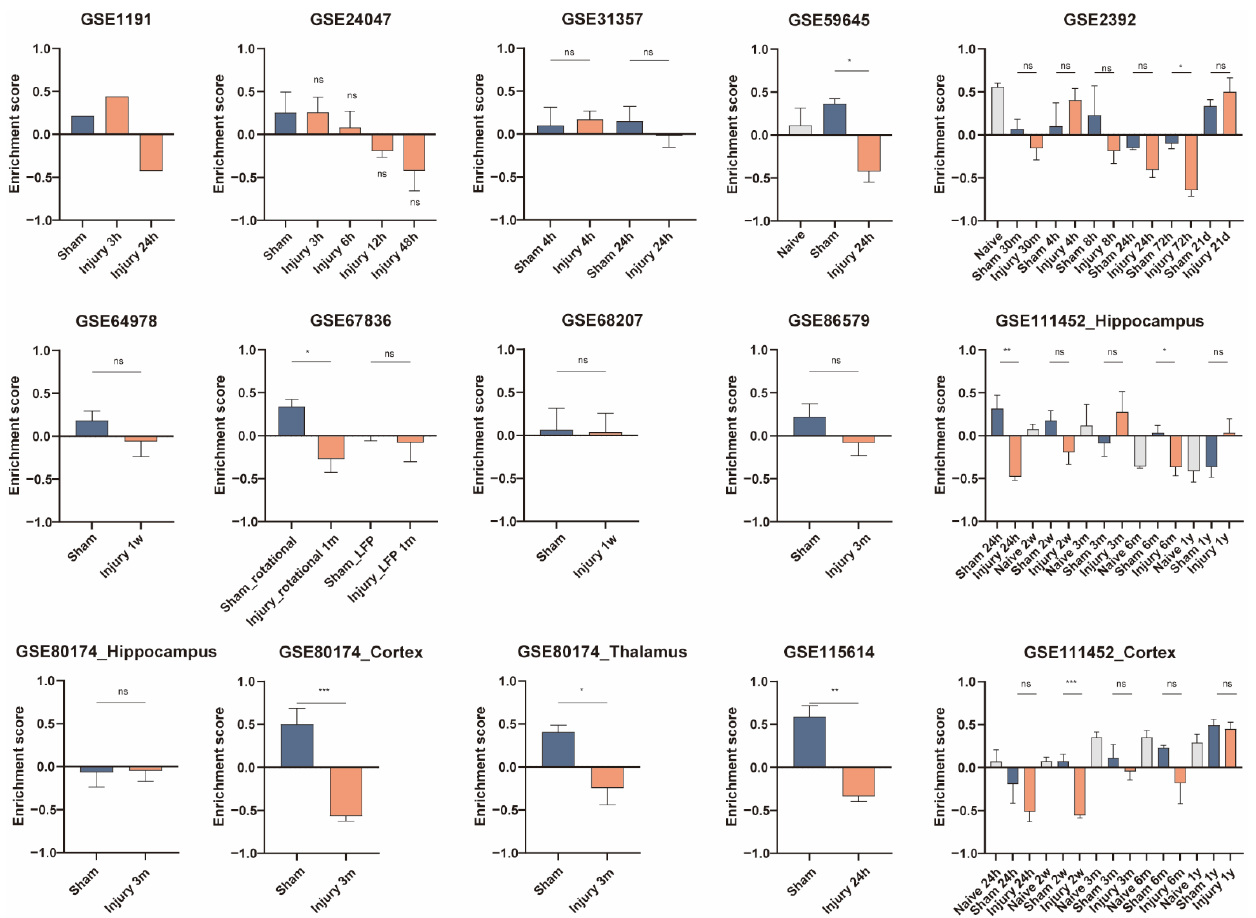
Figure 7. Gene set variation analysis (GSVA) for neuron in the validation datasets. GSVA enrichment scores from the validation data sets are plotted as bar graphs. The GEO accession number of the dataset is labeled in each panel. Samples from multiple regions in one dataset are compared separately. Information is labeled in the corresponding panels if the dataset contains samples with different treatments or harvested at various postinjury time points. For GSE1911, N = 1 for each group; for GSE24047, N = 4 for Sham group and N = 3 for the other groups; for GSE31357, N = 4 for each group; for GSE59645, N = 2 for Sham group and N = 3 for Naïve group and Injury 24-h group; for GSE2392, N = 3 for Naïve, Injury 4-h, Injury 8-h, Injury 24-h, Injury 72-h, and Injury 21-d groups, N = 4 for Sham 30-m and Sham 4-h groups, N = 5 for Injury 30-m group, N = 2 for Sham 8-h, Sham 24-h, Sham 72-h, and Sham 21-d groups; for GSE64798, N = 5 for each group; for GSE67836, N = 4 for Sham_LFP group and N = 3 for the other groups; for GSE68207, N = 4 for each group; for GSE86579, N = 5 for Sham group and N = 6 for Injury 3-m group; for GSE111452_Hippocampus, N = 2 for Sham 24-h group, N = 3 for Injury 24-h group, and N = 4 for the other groups; for GSE80174_Cortex, GSE80174_Hippocampus, and GSE80174_Thalamus, N = 5 for each group; for GSE115614, N = 2 for Sham group and N = 3 for Injury 24-h group; for GSE111452_Cortex, N = 4 for each group. *** p < 0.001, ** p < 0.01, * p < 0.05. Data are shown as means ± SEM.